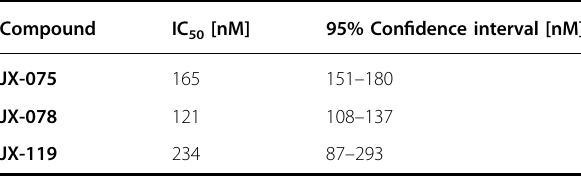
Table 1 Inhibition of [ 3 H]- L -leucine transport into HT-29 cells by JX-075, JX-078, and JX-119.